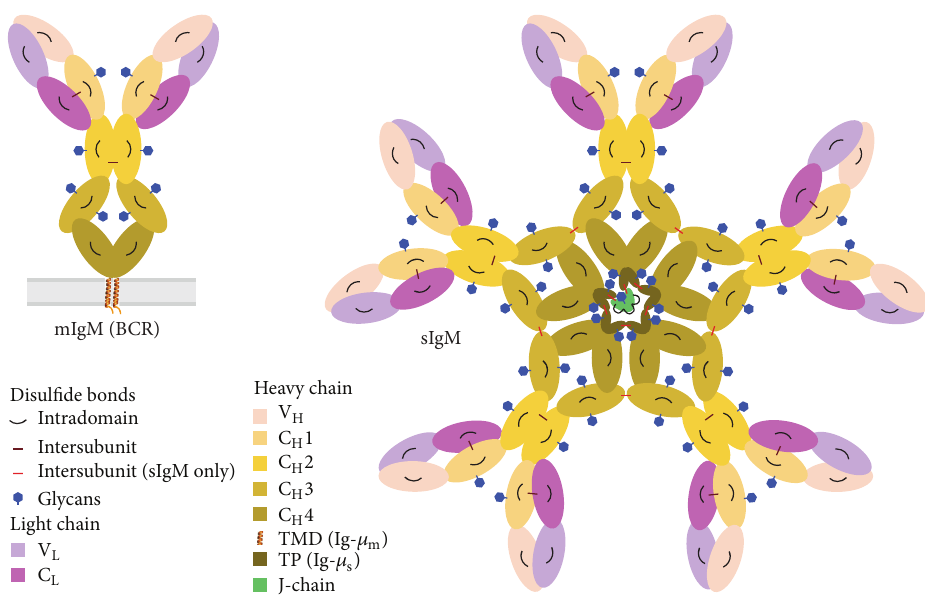
Figure 1: Schematic representation of membrane bound IgM and secretory IgM. B lymphocytes display membrane bound IgM (mIgM)— shown left—on their surface as the core part of the BCR. Once committed to the plasma cell stage they secrete secretory IgM (sIgM) in either “pentameric”—shown right—or “hexameric”—not shown—form. HCs and LCs consist of various Ig-fold domains V H , C H 1–4; V L , C L that are color-coded as indicated. Glycans and intra- and intersubunit disulfide bonds between HCs, LCs, and J-chain are depicted. Note that HC (in mIgM) differs from the Ig- 𝜇 HC (in sIgM) in their C-termini, having a transmembrane domain (TMD) or, respectively, a the Ig- 𝜇 m s cysteine containing tail piece (TP) as indicated.